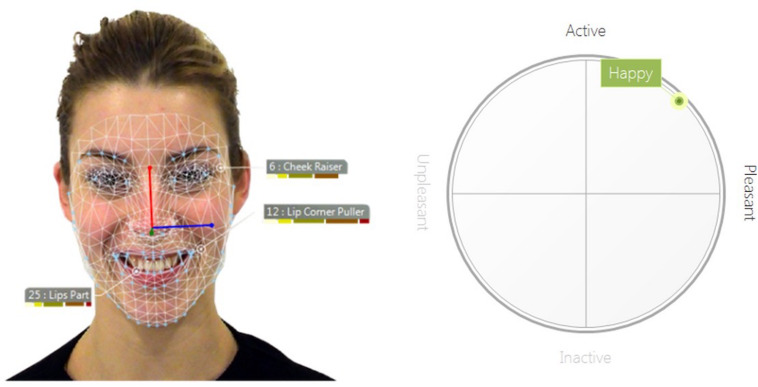
Example of the automatic facial coding analysis of the Facereader software (Noldus Information Technology). (Left) Depicted is a happy facial expression from the ADFES inventory (model F01; Van Der Schalk et al., 2011). The net represents the digital face model which establishes distance measures between distinct facial features. Based on this information, activity of specific action units is estimated. (Right) In a next step, the current profile of action unit activities is integrated to higher order emotion measures (in this case the basic emotion happiness, pleasant valence, and relatively high arousal).